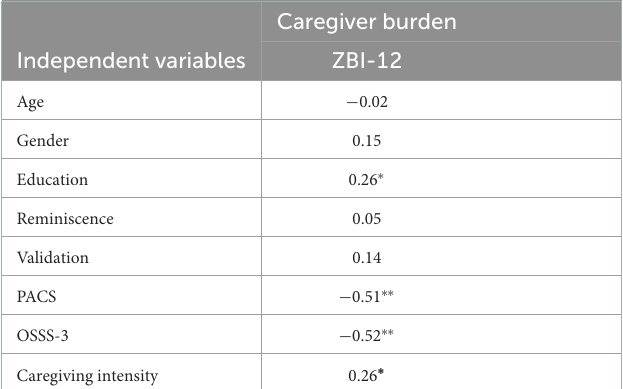
TABLE 3 Correlations of subjective caregiver burden with caregivers’ age, gender, education, applying communication methods, perceived social support, positive caregiving experience, and caregiving intensity in informal caregivers of